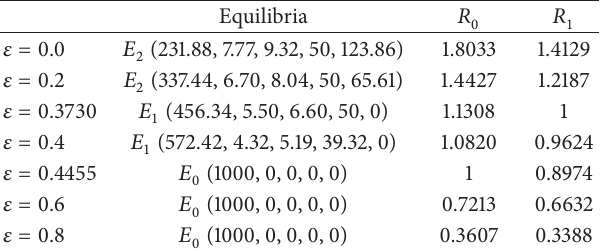
Figure 6: The concentration of uninfected CD4 + T cells for model (104). Table 2: The values of equilibria, 𝑅 0 , and 𝑅 1 for model (104) with different values of 𝜀 .